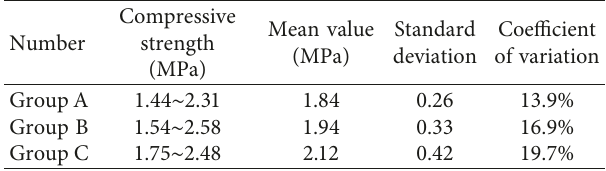
Figure 8: Typical failure mode for the HCCSEB masonry prisms tested under compression. Table 7: The results of the compression tests of HCCSEB masonry prisms.